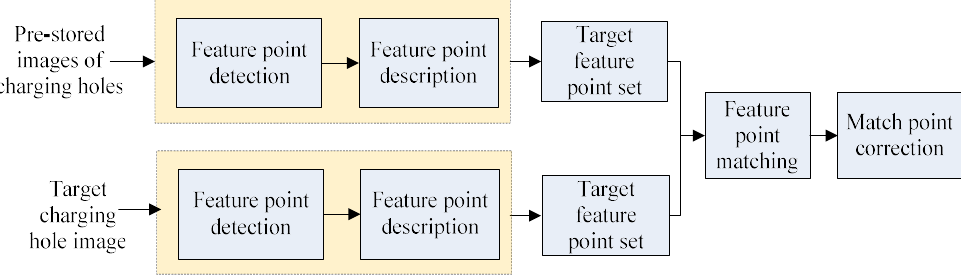
Figure 2. Schematic diagram of charging port feature extraction and matching.